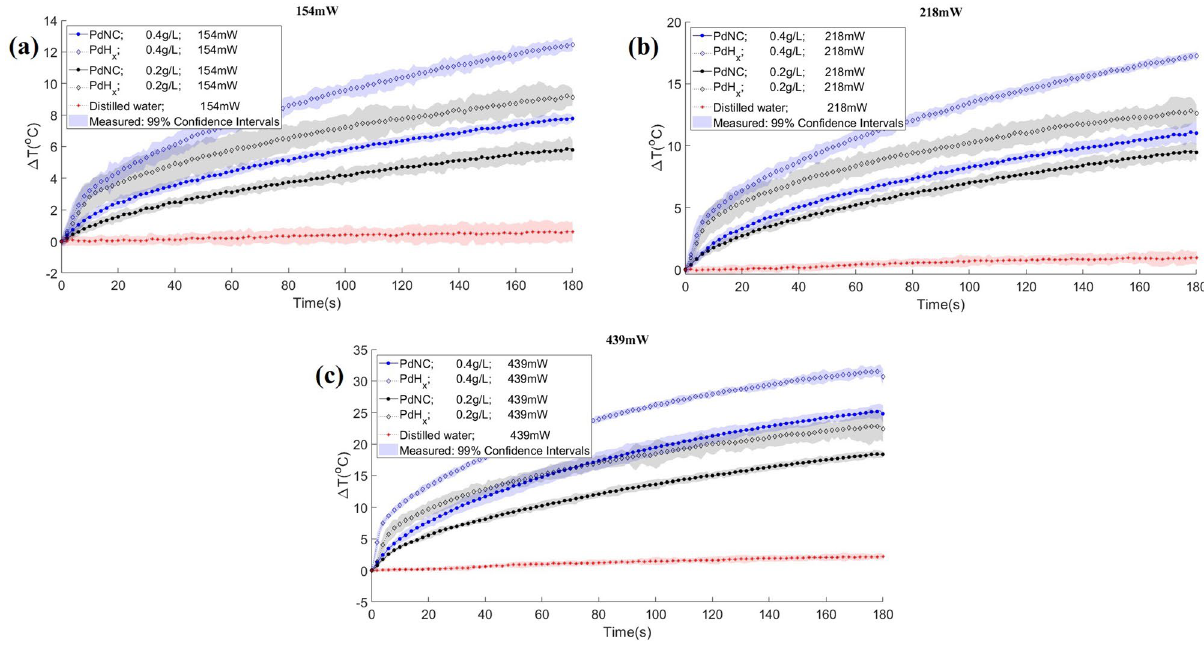
Figure 3. Experimental temperature variations of nanofluids made of Pd nanocubes and Pd hydride nanocubes, with concentrations of 0.2 g/L (black) and 0.4 g/L (blue). Heating performed during 3 min with three powers: ( a ) 154 mW, ( b ) 218 mW and ( c ) 439 mW. Distilled water (red) was used as white.